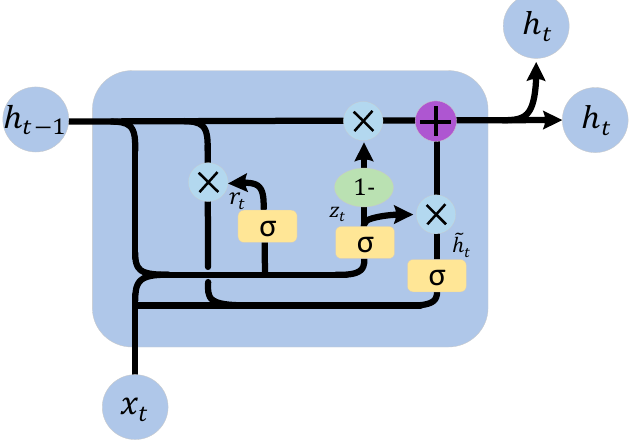
Figure 5. LSTM neuron structure.